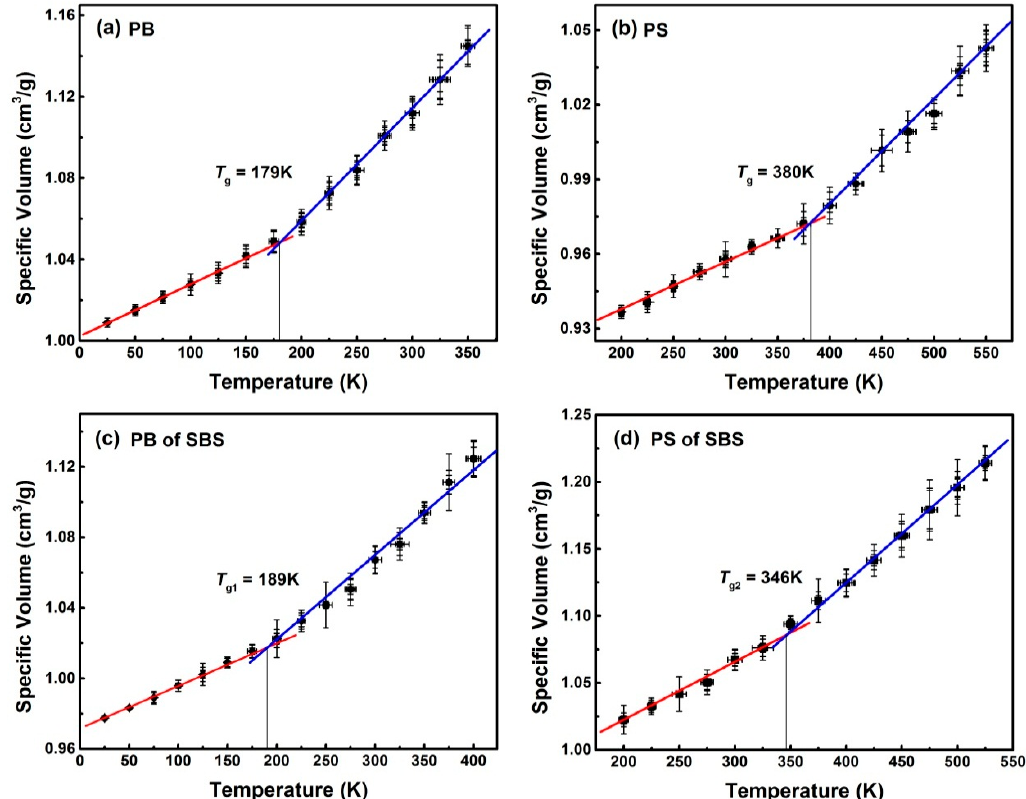
Figure 3. Temperature dependence of the specific volume (the reciprocal of density) for ( a ) PB system, ( b ) PS system, ( c ) PB of SBS system, and ( d ) PS of SBS system. Solid lines are the linear fits of the simulation data and error bars are the related standard deviations. Table 3. Glass transition temperatures ( T g ) by MD simulations and